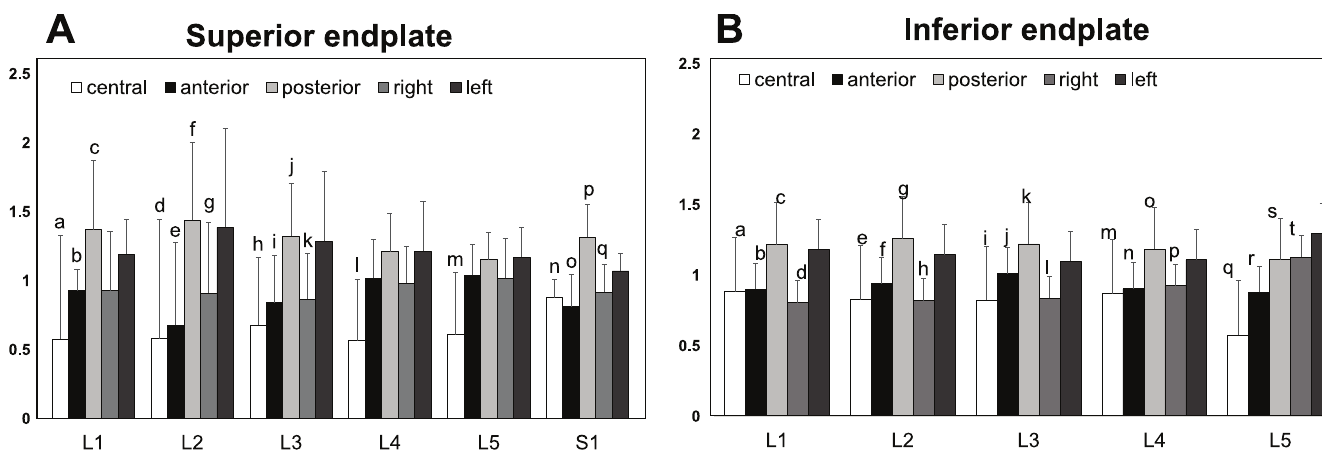
Fig 7. A. Comparison of the regional BMD in the superior endplate. Central: central zone, anterior: anterior zone, posterior: posterior zone, right: right zone, left: left zone. a: compared with Pos (p < 0.02) and Left (p < 0.009) at L1. b: compared with Pos (p < 0.002) and Left (p < 0.004) at L1. c: compared with Right (p < 0.01) at L1. d: compared with Pos (p < 0.03) at L2. e: compared with Pos (p < 0.02) at L2. f: compared with Right (p < 0.005) at L2. g: compared with Left (p < 0.04) at L2. h: compared with Pos (p < 0.002) and Left (p < 0.02) at L3. i: compared with Pos (p < 0.006) at L3. j: compared with Right (p < 0.005) at L3. k: compared with Left (p < 0.04) at L3. l: compared with Ant (p < 0.006), Pos (p < 0.0003), Right (p < 0.008) and Left (p < 0.0001) at L4. m: compared with Ant (p < 0.006), Pos (p < 0.0004), Right (p < 0.02) and Left (p < 0.0003) at L5. n: compared with Pos (p < 0.0001) and Left (p < 0.0004) at S1. o: compared with Pos (p < 0.0001) and Left (p < 0.003) at S1. p: compared with Right (p < 0.0002) and Left (p < 0.0004) at S1.q: compared with Left (p < 0.008) at S1. B. Comparison of the regional BMD in the inferior endplate. Central: central zone, anterior: anterior zone, posterior: posterior zone, right: right zone, left: left zone. a: p < 0.0001 compared with Pos and Left at L1. b: compared with Pos (p < 0.002) and Left (p < 0.0009) at L1. c: compared with Right (p < 0.0001) at L1. d: compared with Left (p < 0.0004) at L1. e: p < 0.0001 compared with Pos and Left at L2. f: compared with Pos (p < 0.0008), Right(p < 0.04) and Left (p < 0.006) at L2. g: compared with Right (p < 0.0003) at L2. h: compared with Left (p < 0.002) at L2. i: compared with Ant (p < 0.009), Pos (p < 0.0001) and Left (p < 0.005) at L3. j: compared with Pos (p < 0.007) and Right(p < 0.02) at L3. k: compared with Right (p < 0.0001) at L3. l: compared with Left (p < 0.02) at L3. m: compared with Pos (p < 0.0001) and Left (p < 0.0004) at L4. n: compared with Pos (p < 0.0001) and Left (p < 0.001) at L4. o: compared with Right (p < 0.0004) at L4. p: compared with Left (p = 0.0644) at L4. q: compared with Ant (p < 0.009), Pos (p < 0.002), Right(p < 0.0001) and Left (p < 0.0001) at L5. r: compared with Pos (p < 0.05), Right(p < 0.0001) and Left (p < 0.0001) at L5. s: compared with Left (p < 0.006) at L5. t: compared with Left (p < 0.04) at L5.